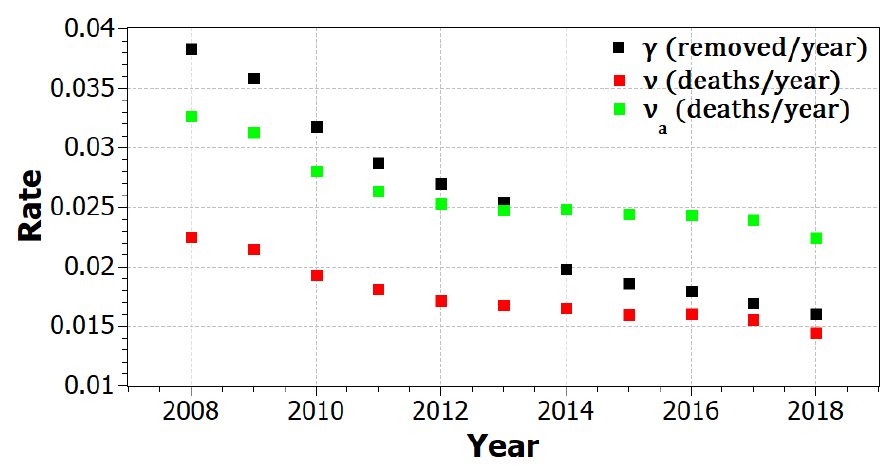
Figure 2. The values for γ , ν , and ν a from the CDC data from 2008 to 2018. Note: 2012 is when PrEP was approved for use by the FDA [4].